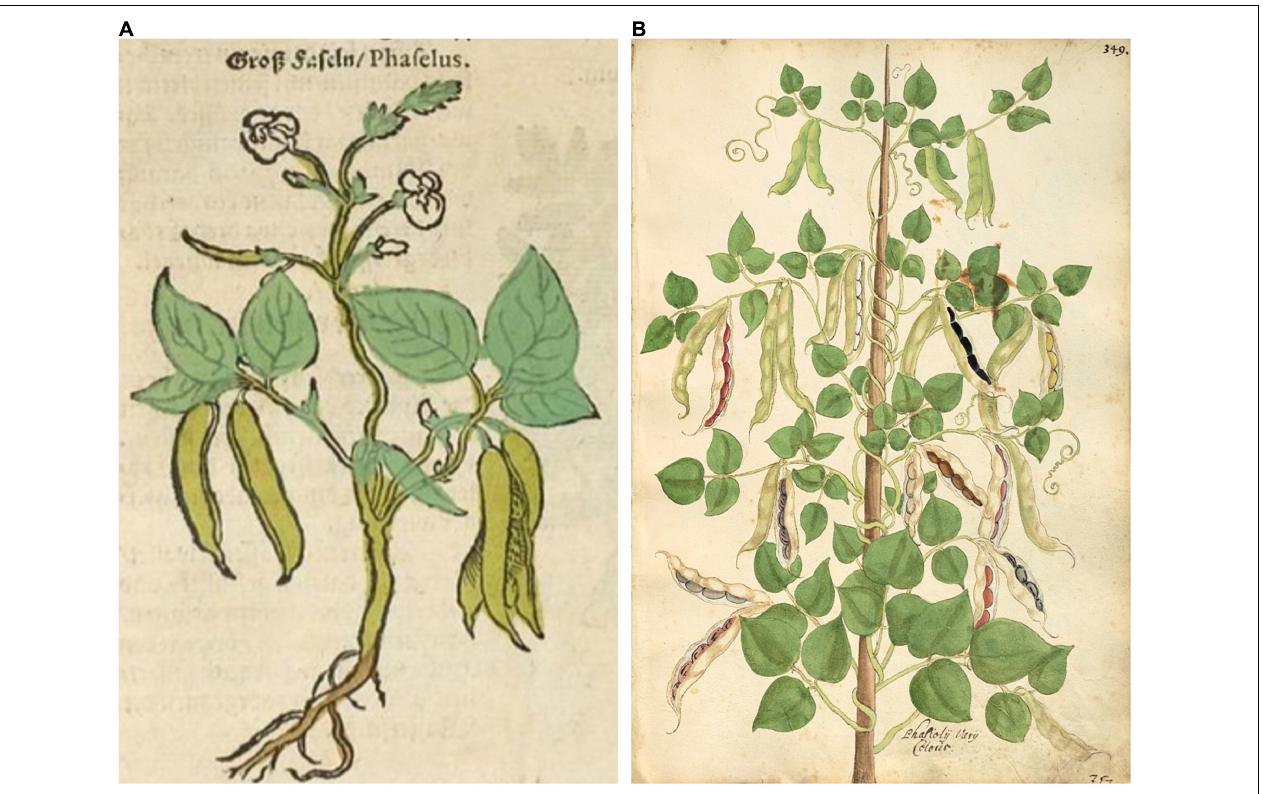
FIGURE 7 | Woodcuts of common bean from 16th century herbals. (A) Roesslin (1550). Kreuterbuch. Source: Public domain; National Library of the Czech Republic (Google Books). (B) Oellinger (1553), Magnarum Medicinae partium herbariae ... Folio 349, Phasioli Vary Coloris . Source: Public domain; Universitätsbibliothek Erlangen-Nürnberg,